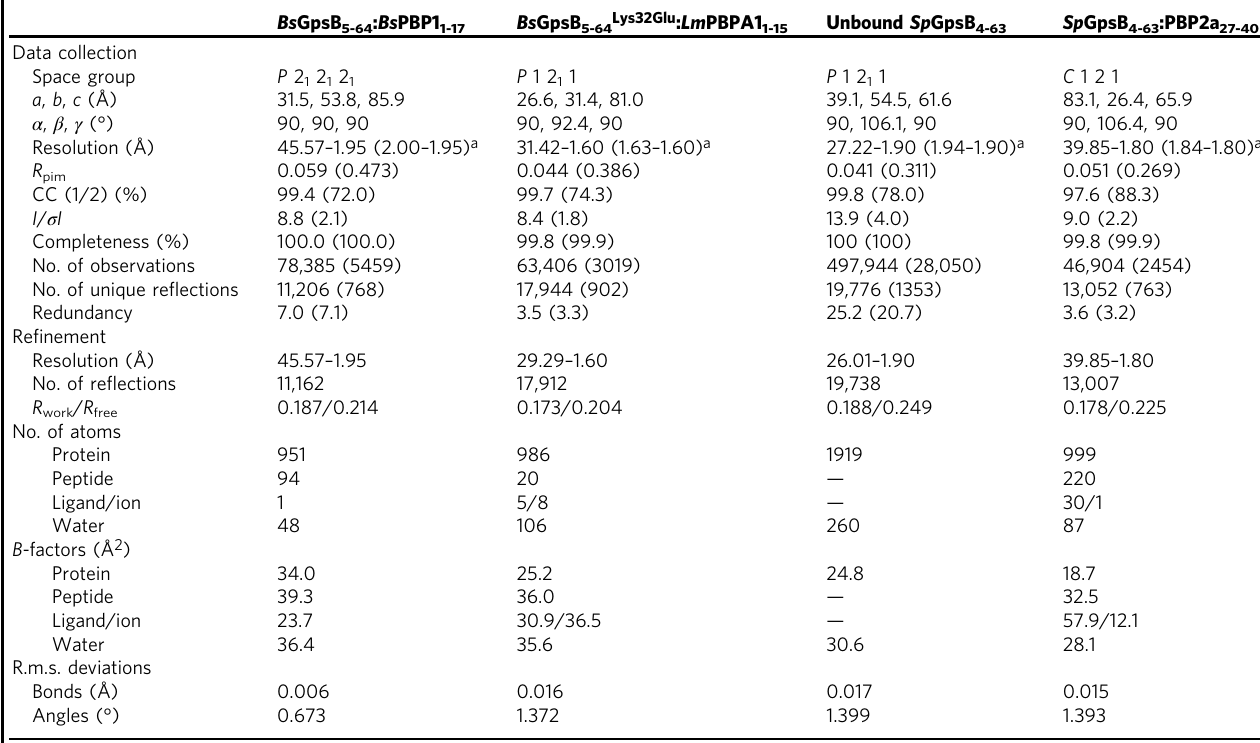
Table 1 Data collection and re fi nement